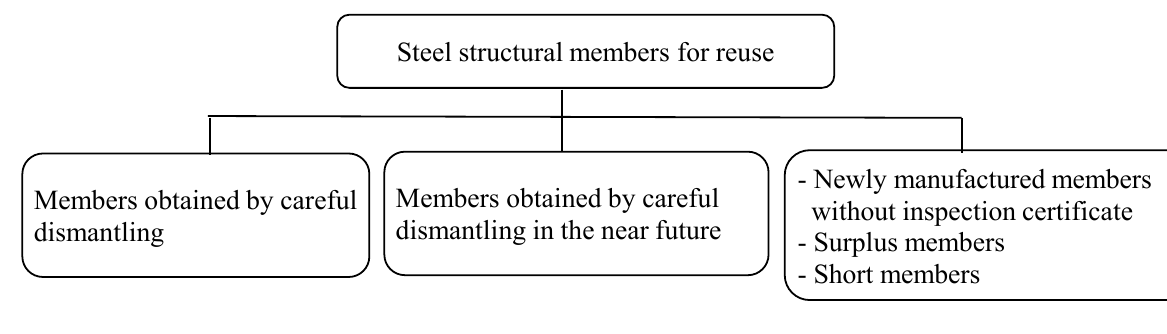
Figure 4. Steel structural members for